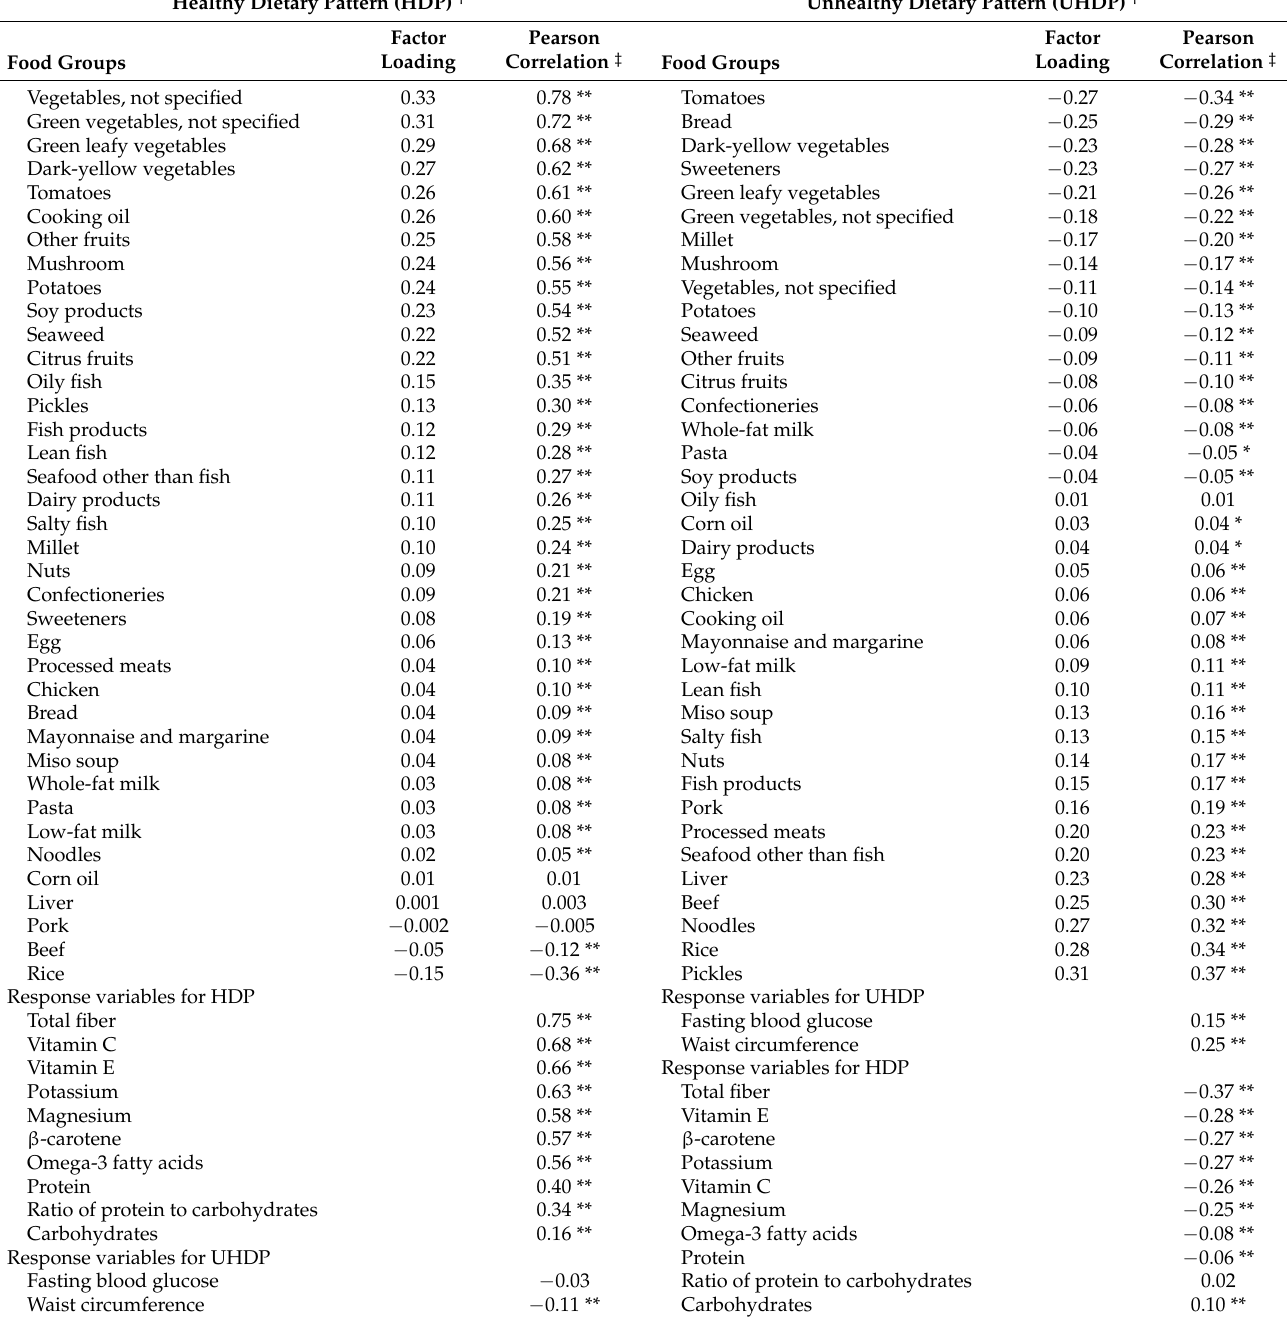
Table 1. Factor loadings and Pearson correlations between dietary pattern scores and consumption of food group, nutrient intakes, baseline waist circumference and fasting blood glucose for the Aichi Workers’ Cohort ( n = 2944),